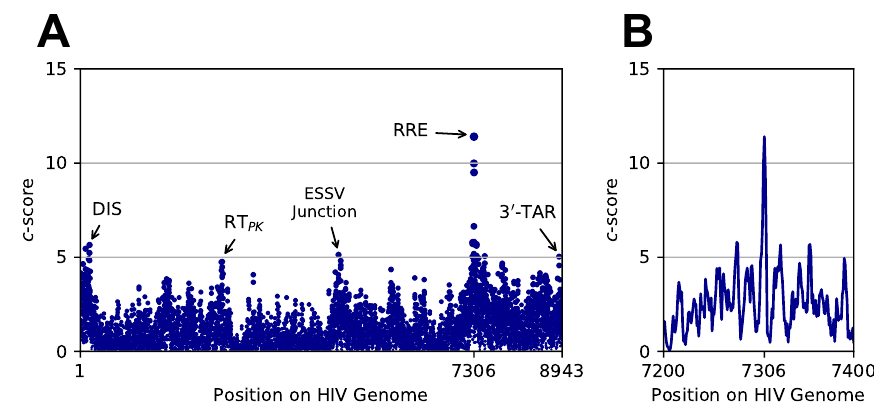
Figure 5. patteRNA scores when searching for the 4SL native structure of RRE across human immunodeficiency virus (HIV) genome profiles. ( A ) c -scores across the entire HIV-1 RNA genome as probed with N -methylisatoic anhydride (NMIA) by Siegfried et al. The peak at nucleotide 7306 corresponds to the known start site of the RRE. Other labeled peaks correspond to known structured elements in HIV-1. Scores end at nucleotide 8943 as this is the last location in the 9174-nt genome able to accept the 232-nt target paths. ( B ) Inset of c -scores around the RRE start